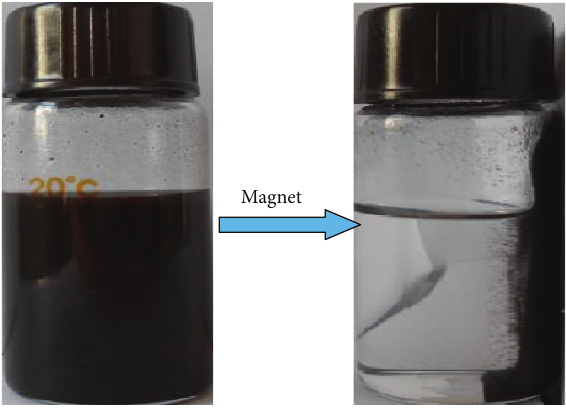
Figure 4: Photos of Fe 3 O 4 /MWNTs under a magnetic field.